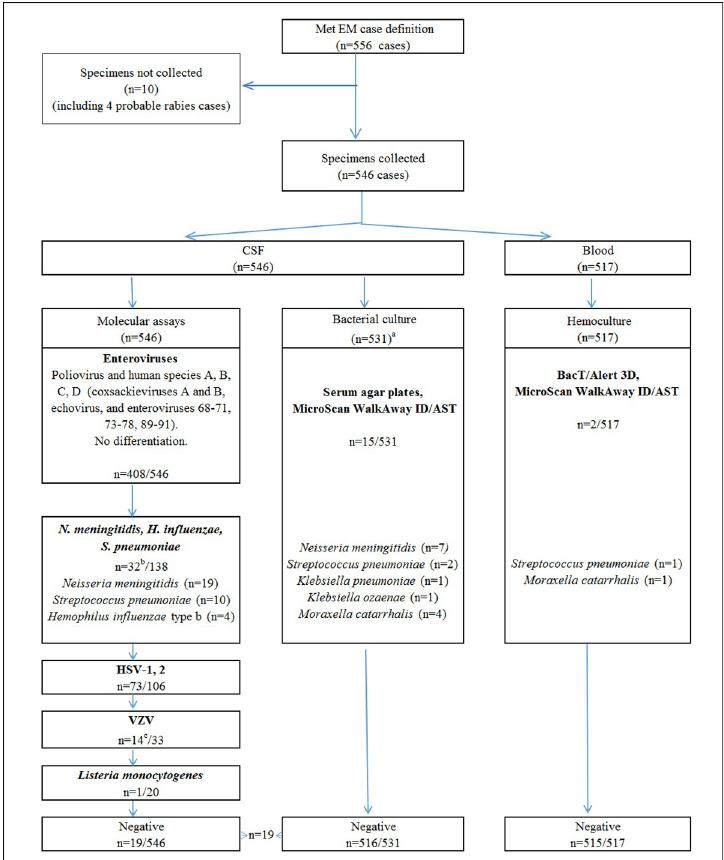
Fig 1. Flow chart for the diagnostic algorithm performed with associated test results. 546 CSF samples and 517 blood samples were taken from 556 patients. Out of 546 collected CSF samples, all 546 were tested in molecular assays and 331 were tested for bacterial culture. In molecular assays 494/546 samples were positive for viruses, 33/546 samples were positive for bacteria, and one sample was positive for both. 15/531 CSF samples and 2/517 blood samples were positive for bacterial culture. Nineteen CSF samples remained negative. a 15 cases with mild symptoms had less than 1ml cerebrospinal fluid collected and culture was not conducted. b One sample was positive for both N . meningitidis and Hib. c One sample was positive for both N . meningitidis (tested at the earlier step) and